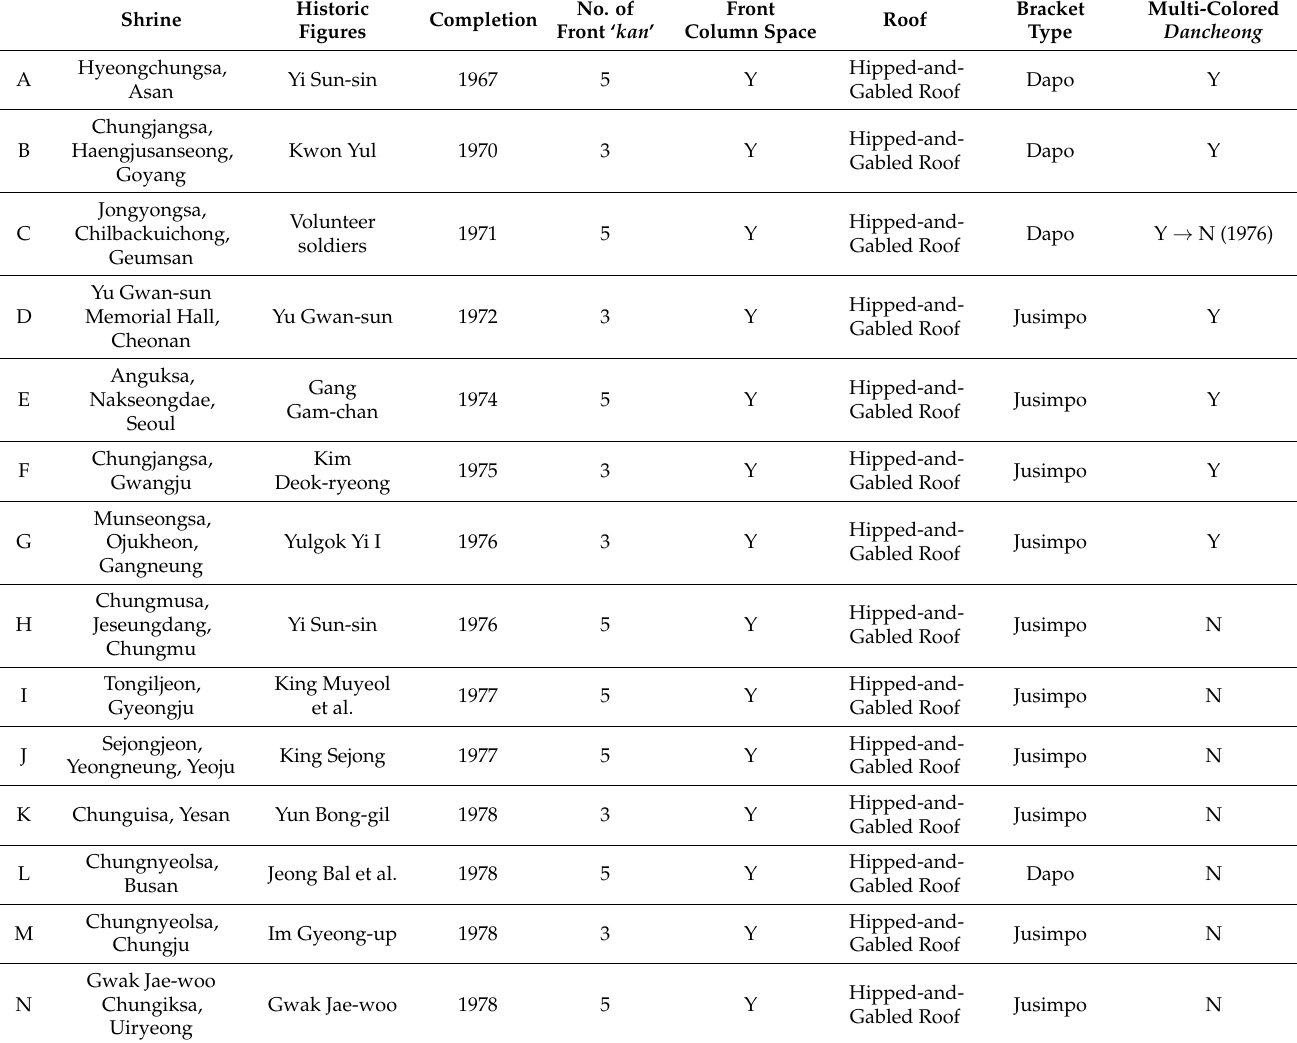
Table 1. Comparison of Features in Different